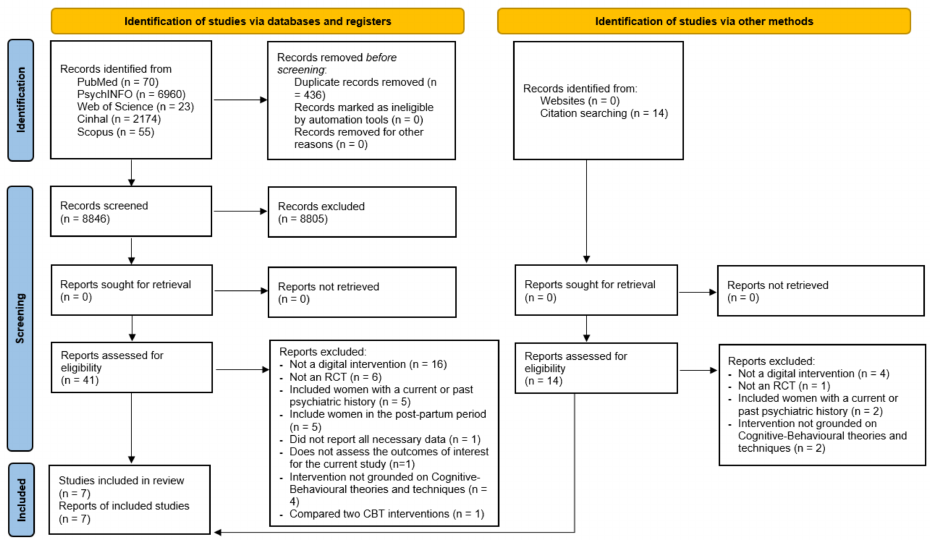
Figure 1. PRISMA 2020 flow diagram, including searches of databases, registers, and other sources